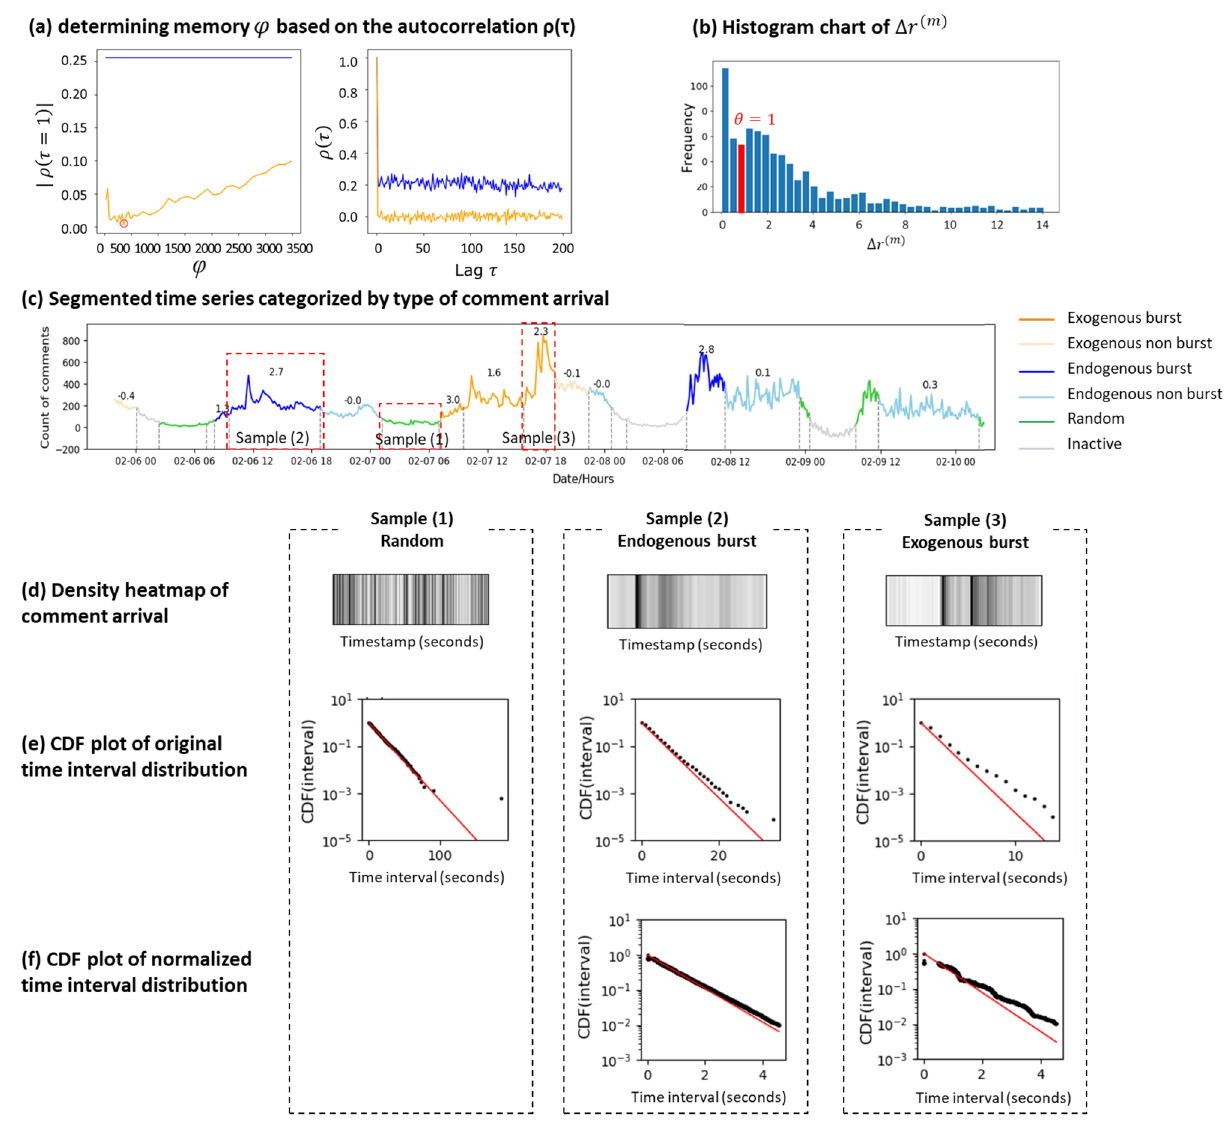
Figure 4. Example of the rule-based algorithm to classify time series segments. ( a ) An example of determining memory φ based on autocorrelation function ρ(τ). The blue line represents the autocorrelation value of the original time interval { (cid:31) t j } and the orange line represents that of the normalized time interval { b j }. The first sub-figure shows result of |ρ(1)| based on different φ. |ρ(1)| reaches its minimum value close to 0 at φ = 360 s. This indicates that at φ = 360 s, the normalized time series is not autocorrelated anymore. The second sub-figure shows the autocorrelation function before and after normalization based on φ = 360 s. It obviously shows that the autocorrelation is removed after the normalization. ( b ) Histogram chart of � r ( m ) , the increment rate of number of comments. The bar in red (where � r ( m ) = 1) represents the threshold value θ . ( c ) The result of burst analysis on a segmented time series (the unit time is 600 s), from which we picked 3 samples with different scenarios as circled in red box. The numbers marked above the line chart are increment rate � r ( m ) of each segment. ( d ) Density heat map of comments arrival. X-axis represents the timestamp of comment arrival. The shorter the interval between the two comments, the darker the vertical lines are. ( e ) Semi-log CDF plot of the original time interval and a fitting exponential distribution line. X-axis represents the time interval in seconds and y-axis represents the cumulative distribution function of interval. The p-values of Chi-square test on samples 1, 2 and 3 are 0.23, 6.58 × 10 − 212 , and 1.09 × 10 − 209 , respectively. Because sample 1’s p-value is significant (> 0.05) enough to be accepted as an exponential distribution, it is classified as scenario 1-random. ( f ) Semi-log CDF plot of the normalized time interval and fitting exponential distribution line. The p-value of Chi-square test on sample 2 and 3 are 1.43 × 10 − 3 and 4.62 × 10 − 5 , respectively. Because sample 2’s p-values is significant (> 0.0005) enough to be accepted as an exponential distribution and its increment rate is larger than θ = 1, sample 2 is classified as an endogenous burst while sample 3 is classified as an exogenous